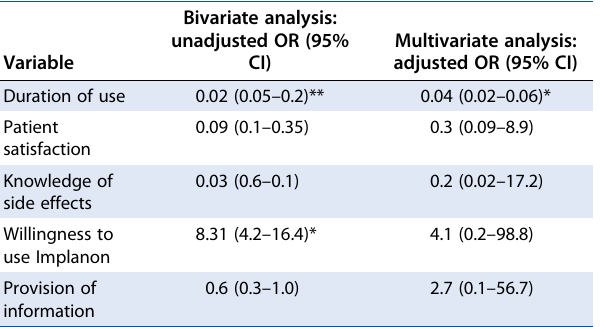
Table 5: Bivariate and multivariate analysis of association between participants ’ knowledge and attitude towards Implanon and Implanon uptake at a district hospital and PHC clinics between December 2016 and May 2017 ( n = 385)